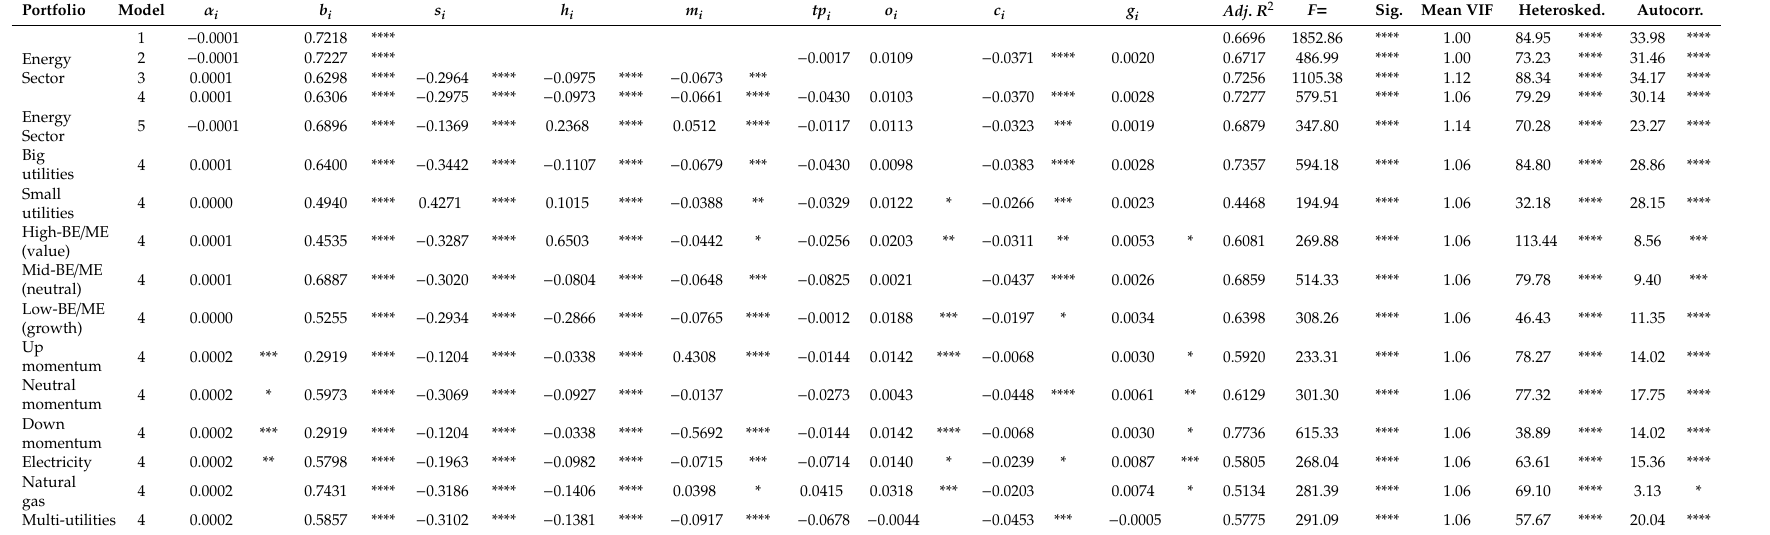
Table 2. Capital asset pricing model (CAPM), four-factor and local augmented asset pricing